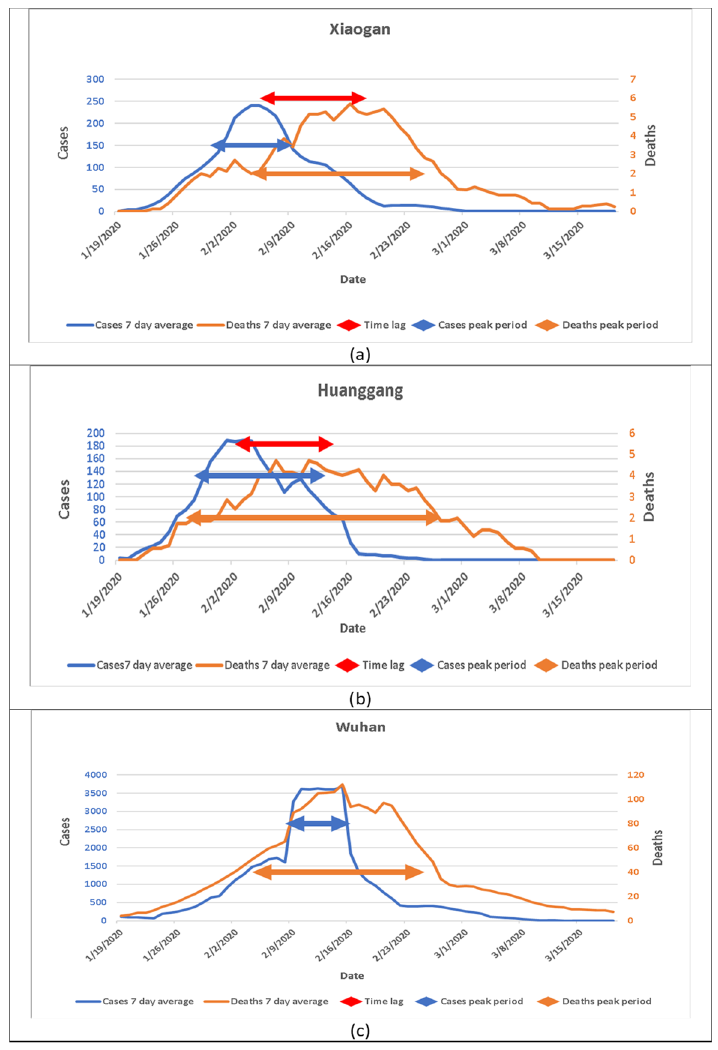
Figure 1. Patterns of cases and deaths from COVID-19 in three cities in China’s Hubei Province from January 19 to March 19, 2020. ( a ) New cases and deaths in Xiaogan; ( b ) New cases and deaths in Huanggang; ( c ) New cases and deaths in Wuhan.